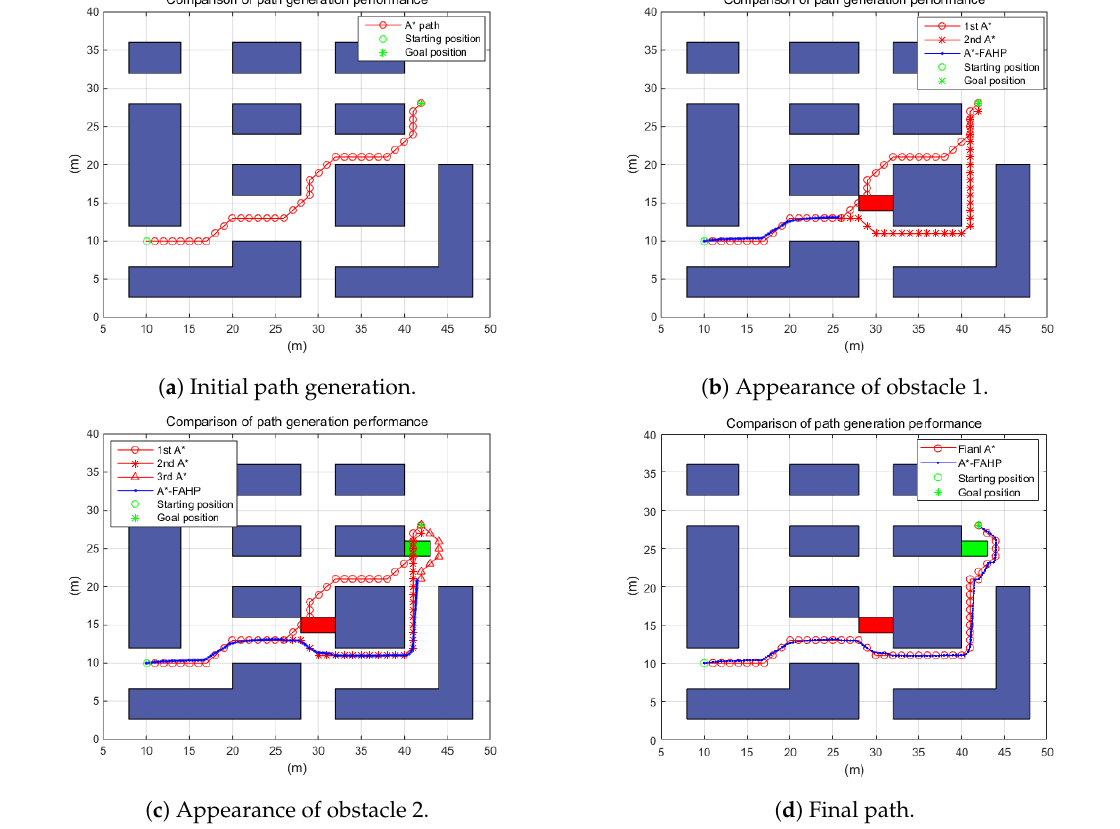
Figure 12. Path planning performance under the dynamic